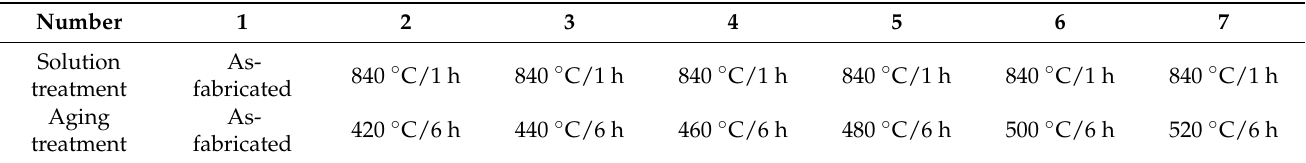
Table 3. Experimental design of temperature